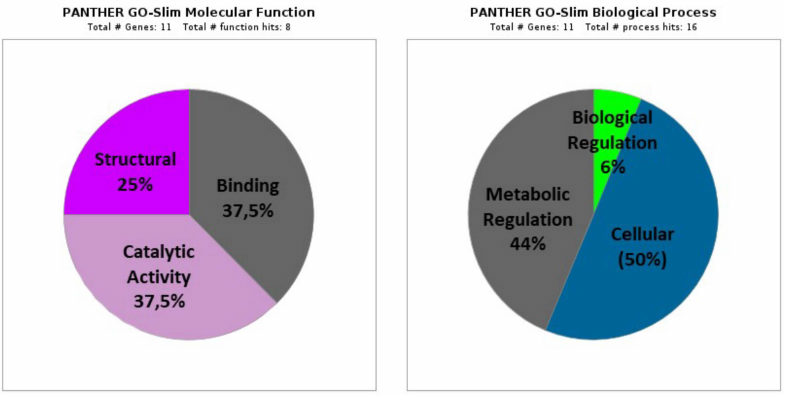
Figure 1. GO-slim categories of DAPs in the comparison between the Ctrl and HTX